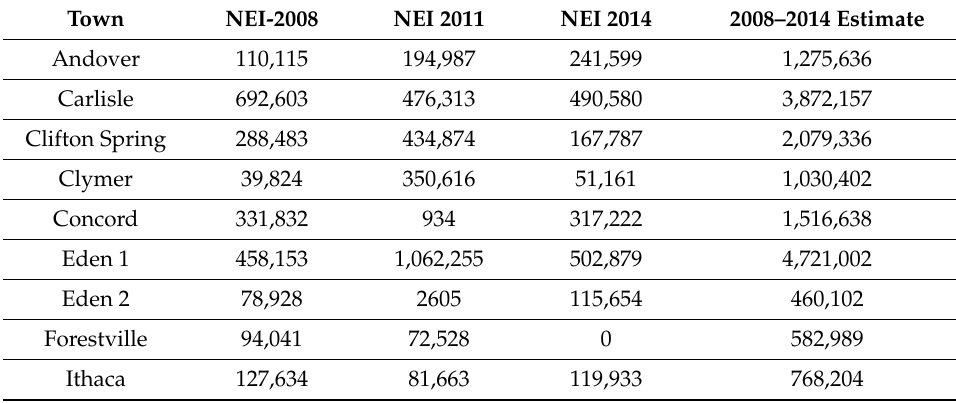
Table 3. USEPA NEI emissions (pounds) by town: